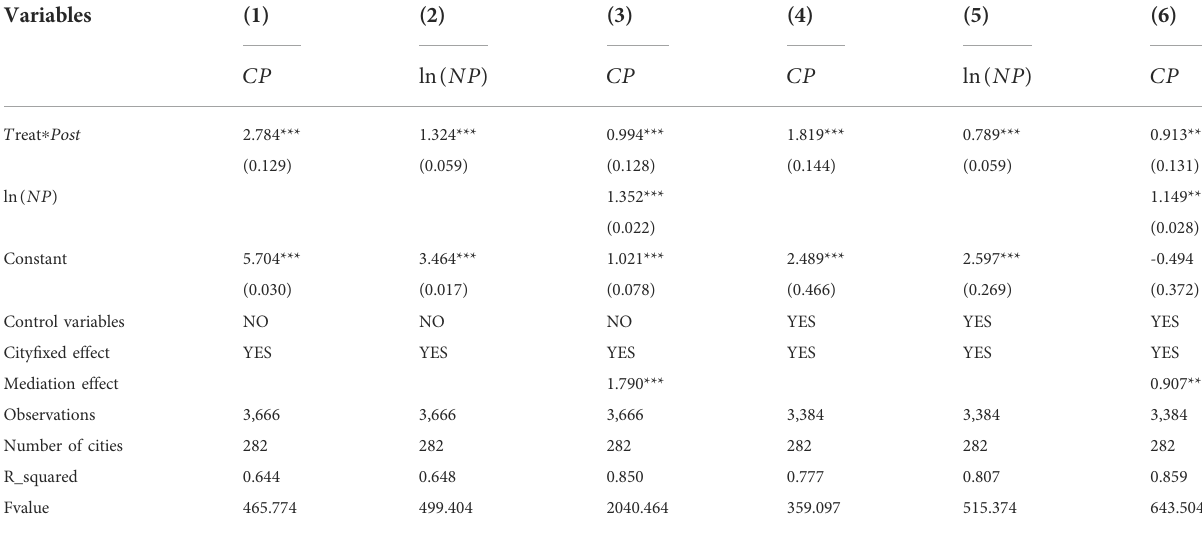
TABLE 10 Estimation results based on the number of green patent applications.